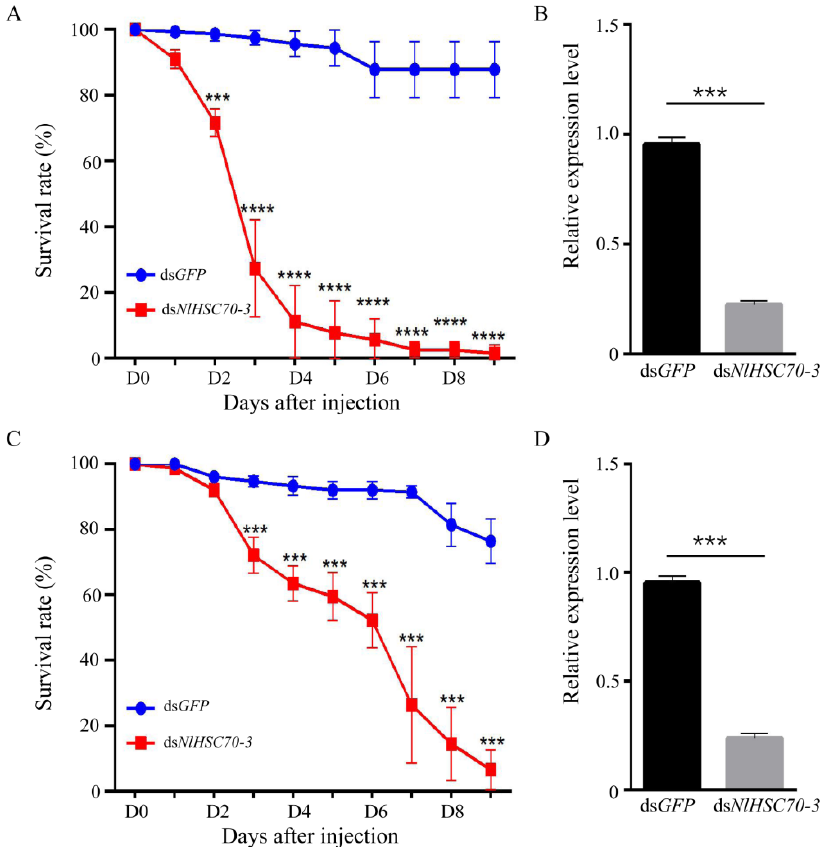
Figure 4. NlHSC70-3 is critical to survival of BPH. ( A ) The survival rate of 3rd instar BPH injected with ds NlHSC70-3 . ( B ) Transcript levels of NlHSC70-3 in the control and ds NlHSC70-3 in 3rd instar nymphs . ( C ) The survival rate of 5th instar BPH injected with ds NlHSC70-3 . ( D ) Transcript levels of NlHSC70-3 in the control and ds NlHSC70-3 in 5th instar nymphs . Data are mean ± s.d. ( n = 3 biologically independent samples), as analyzed by two-tailed Student’s t -test. p < 0.001 was considered statistically significant (***), and p < 0.0001 was considered statistically significant (****).